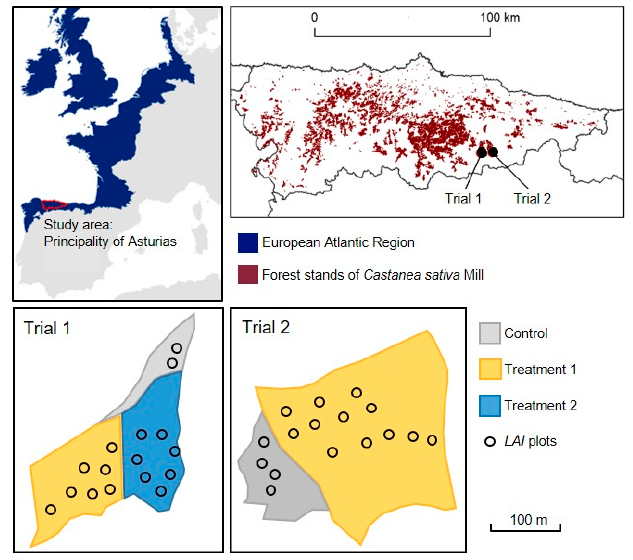
Figure 1. Study area located in the north of Spain and location and distribution of the Leaf Area Index ( LAI ) plots for the different treatments in the two trial sites. Table 1. Summary of forest inventory data for Trial 1 and Trial 2. Trial 1 Trial 2 Treatment